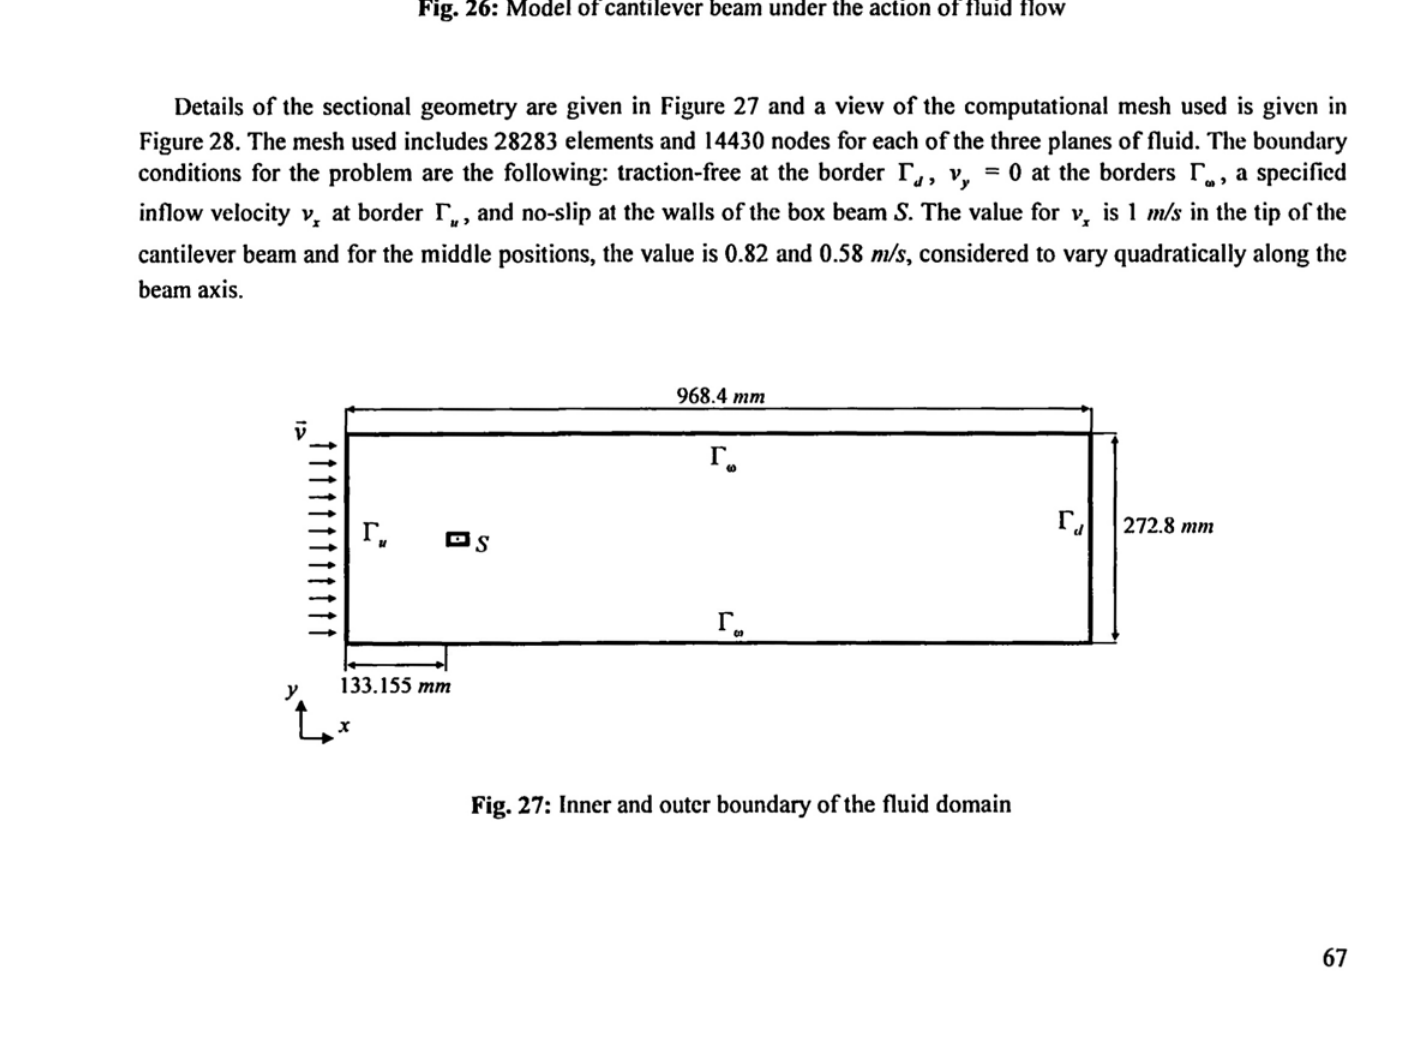
Fig. 26: Model of cantilever beam under the action of fluid flow